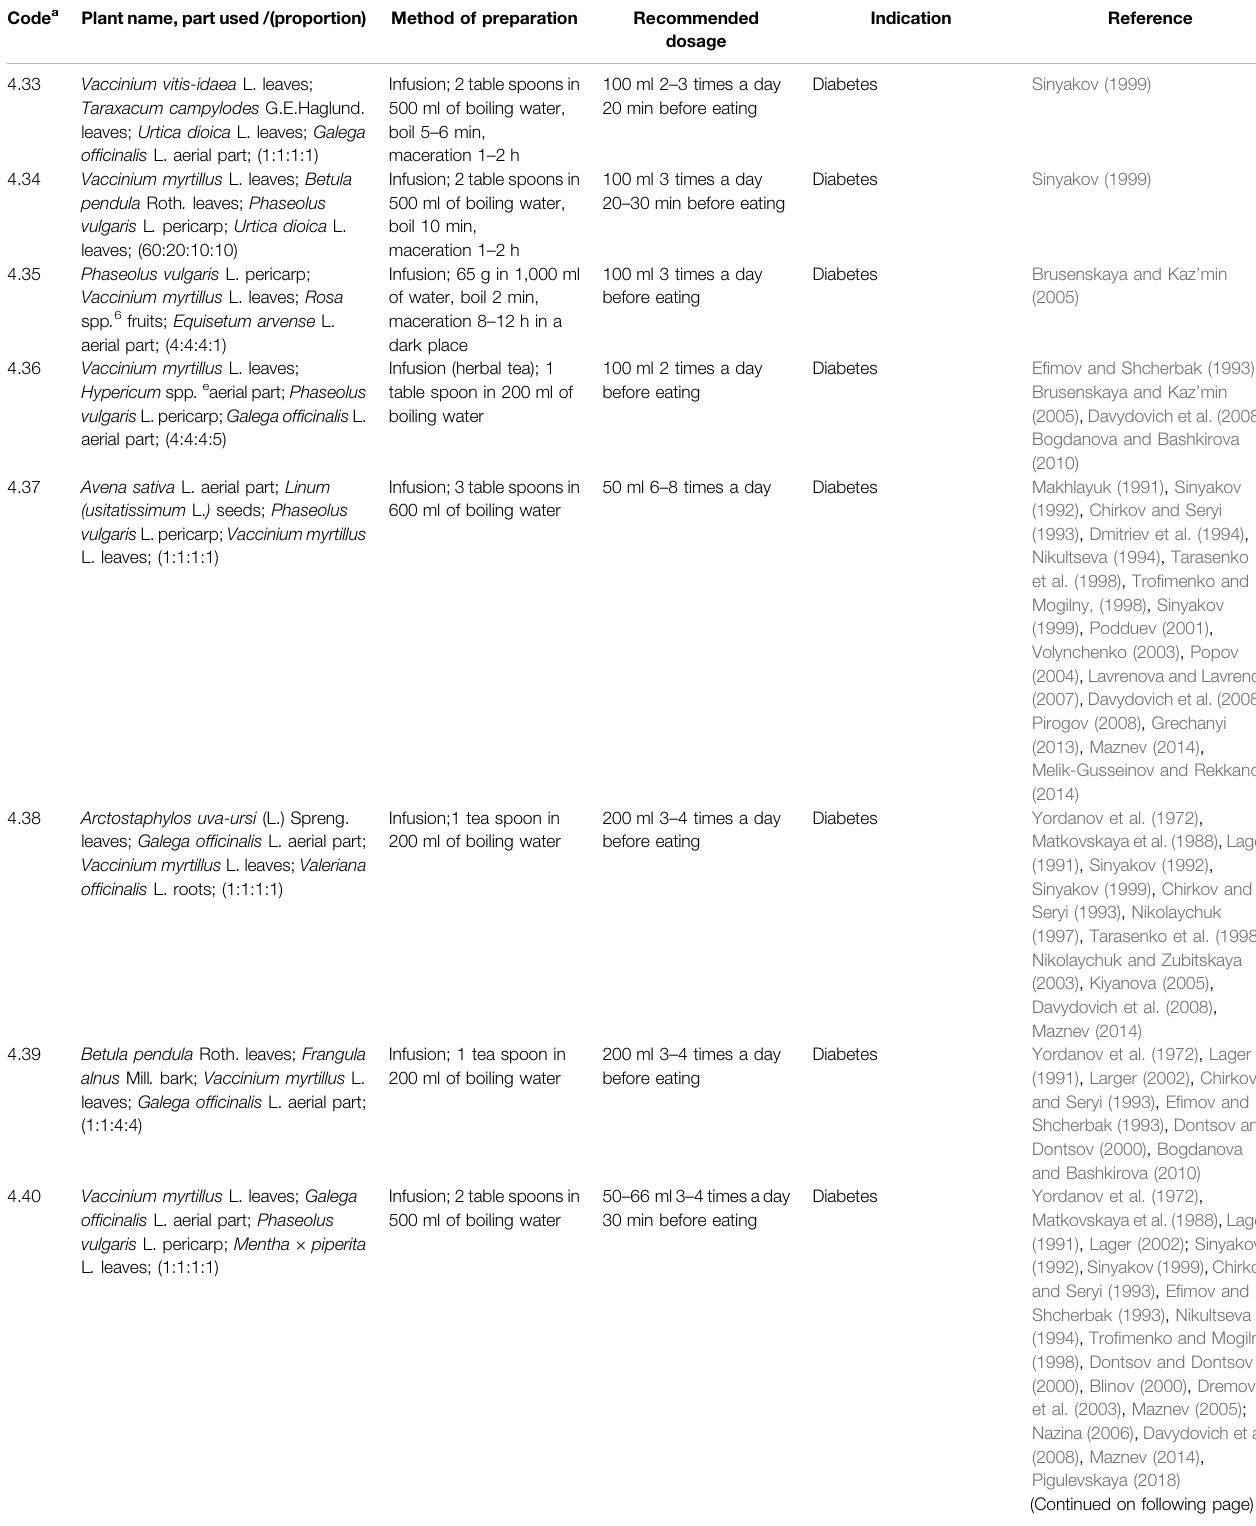
TABLE 1 | ( Continued ) The list of medical species used for the management of diabetes and related disorders in Russia. Code a Plant name, part used /(proportion) Method of